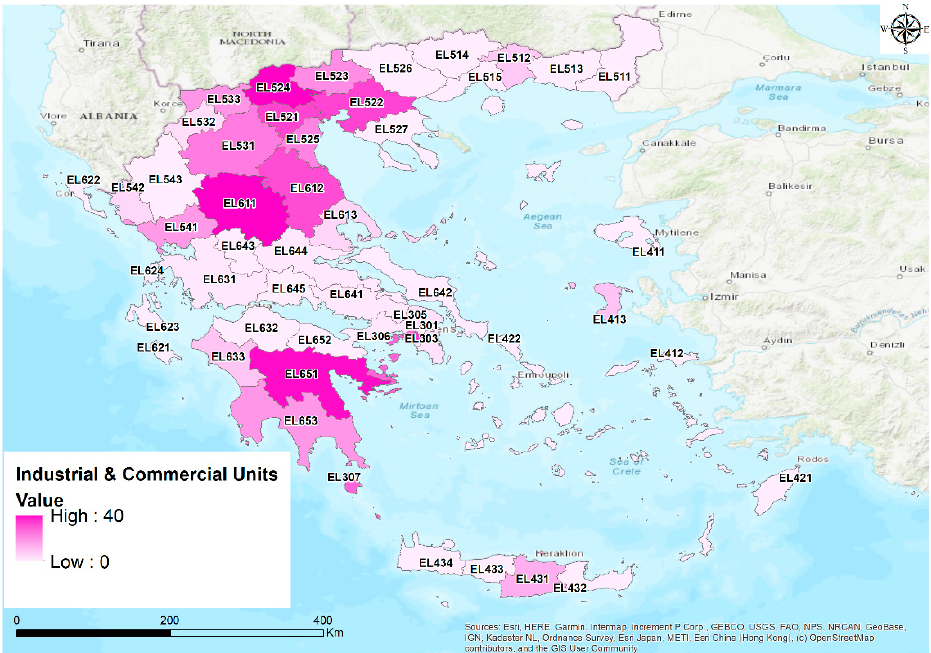
Figure 6. Spatial distribution of the ratio of industrial and commercial units in flood zones per NUTS 3.